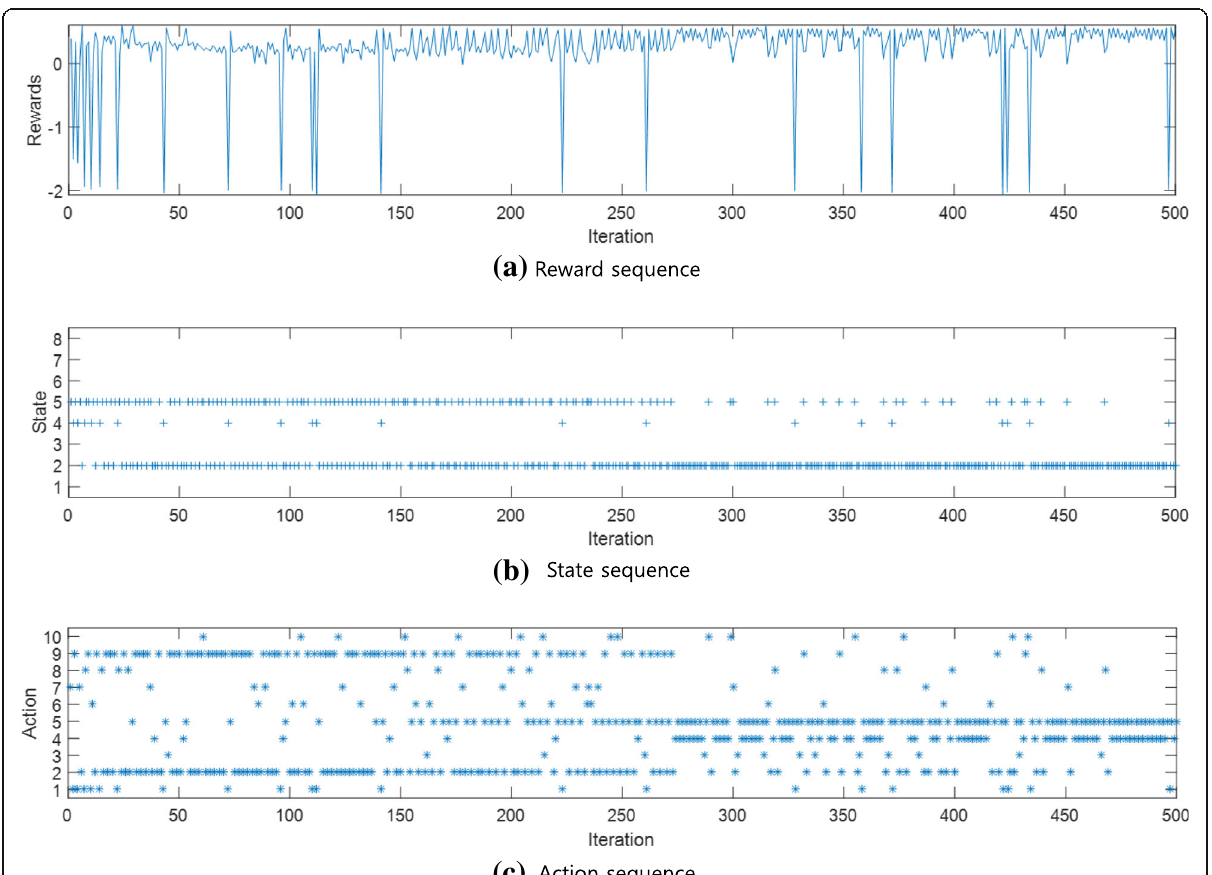
Fig. 12 The change of a rewards, b states, and c actions according to iteration at a low DDR of 40 kbps. The temporary low reward value is due to the random action of Q-learning exploration. The agents visits the state 2 more often than the states 4 and 5 over time as seen in Fig. 11b. As shown in Fig. 11a, the action in c mainly visits channel 2 or 3 and is adaptive to the DDR at the latest possible moment, even if a channel from band group 2 is selected or a channel from band group 1 offering a high data rate is selected. c represents how the agent selects the channels in band group 1 suitable for the DDR over time. Therefore, we can see that the agent operates according to the designed